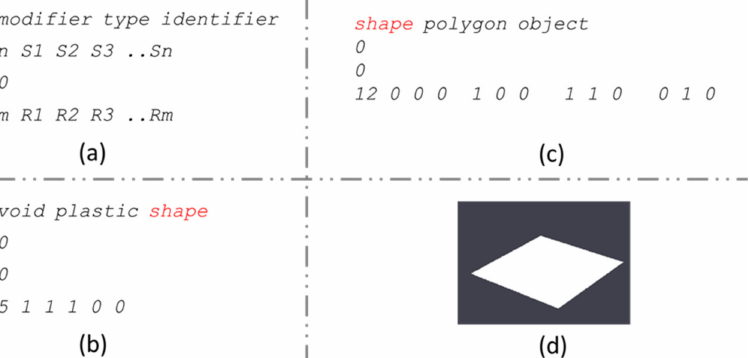
Figure 6. Specifying materials and shapes in RADIANCE. ( a ) Shows the general template. ( b , c ) Pro- vide examples of a material type and shape type respectively. ( d ) shows a visualization of the geometry defined through the combination of ( b , c